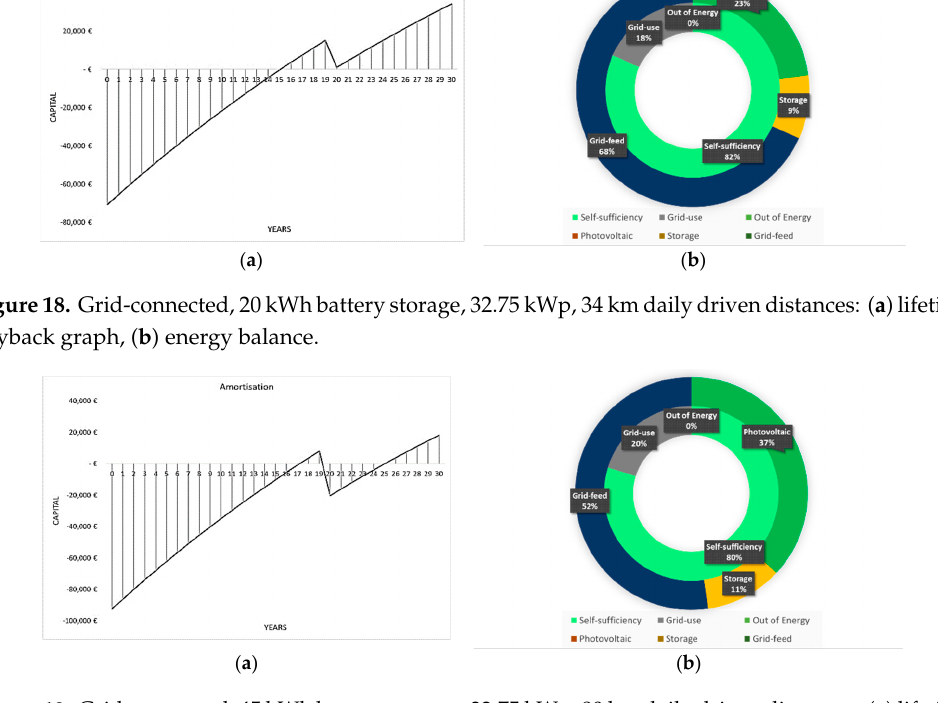
Figure 19. Grid-connected, 45 kWh battery storage, 32.75 kWp, 80 km daily driven distances: ( a ) lifetime payback graph, ( b ) energy balance.